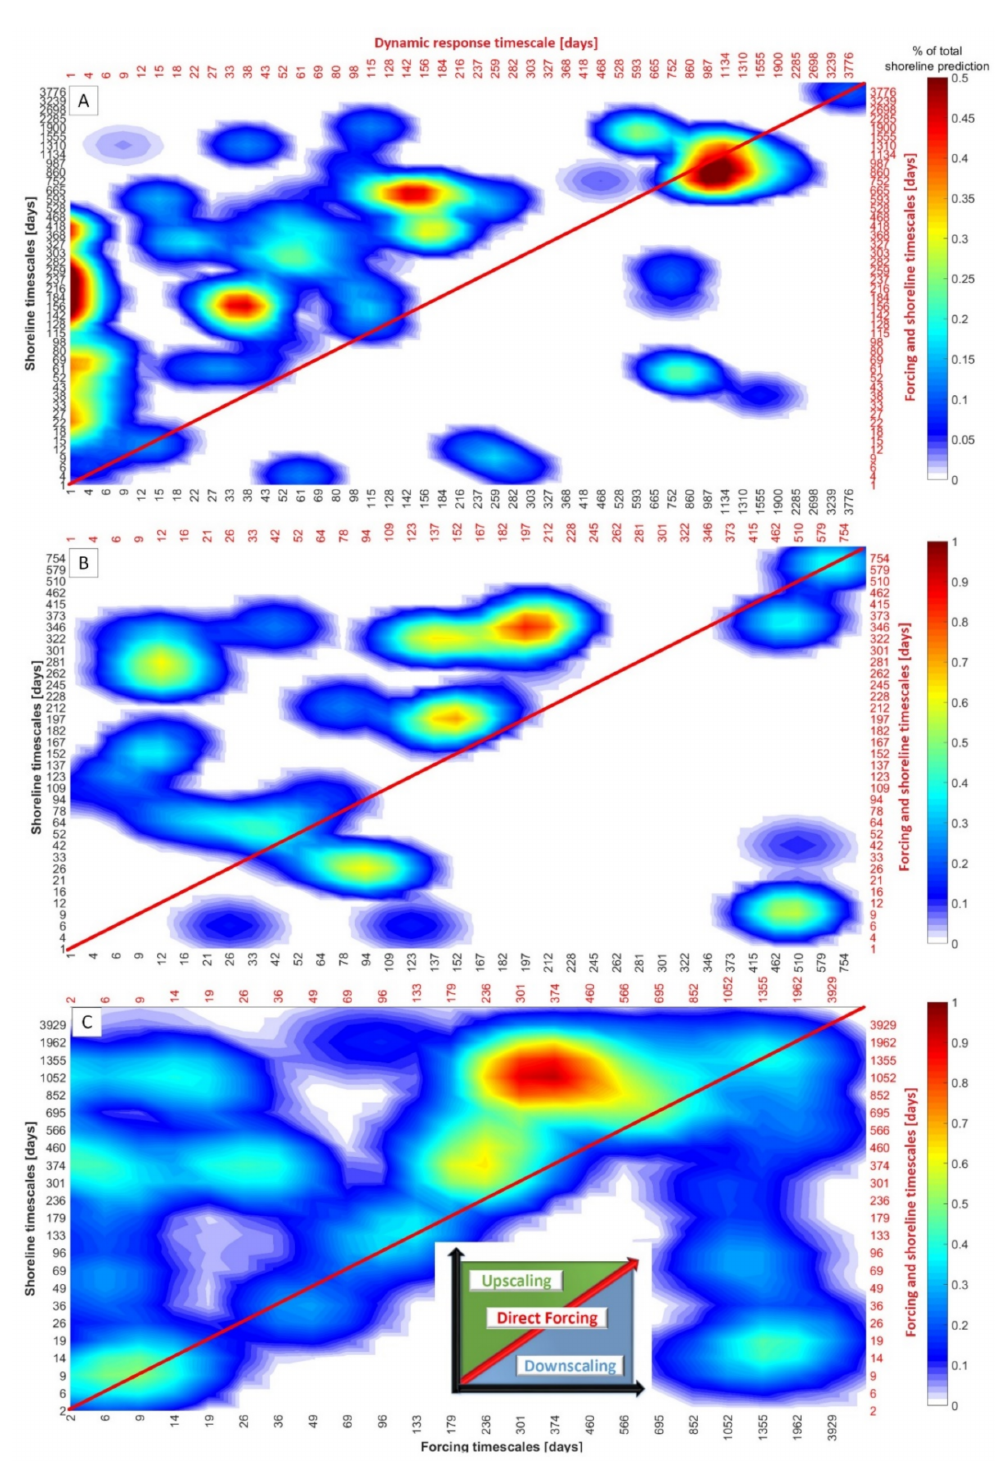
Figure 8. Timescale interactions at Narrabeen ( A ), Nha Trang ( B ) and Tairua ( C ) and the corresponding legend ( C ). The diagonal represents signals modelled with the direct forcing approach where the black axes (from x to y) can be used to check which timescales are involved. For the upscaling approach (all patches in the upper left corner) the black axes can be used as well. The lower right corner of the grid represents signals generated with the downscaling approach. For those patches the red axes need to be used. The color indicates the percentage of those signals to the total modelled shoreline. A smooth function is used to visually highlight the most dominant timescale